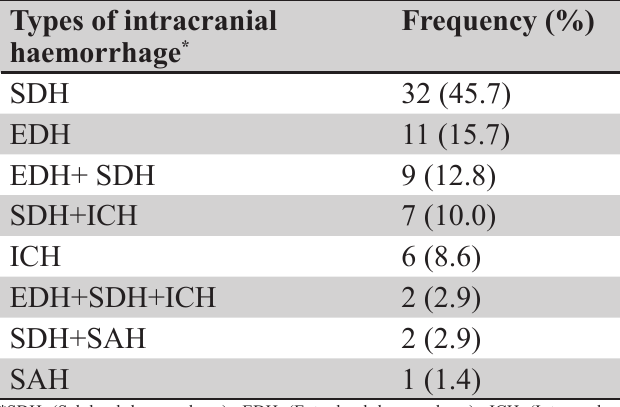
Table 4. Pattern of intracranial haemorrhage (n=70) Types of